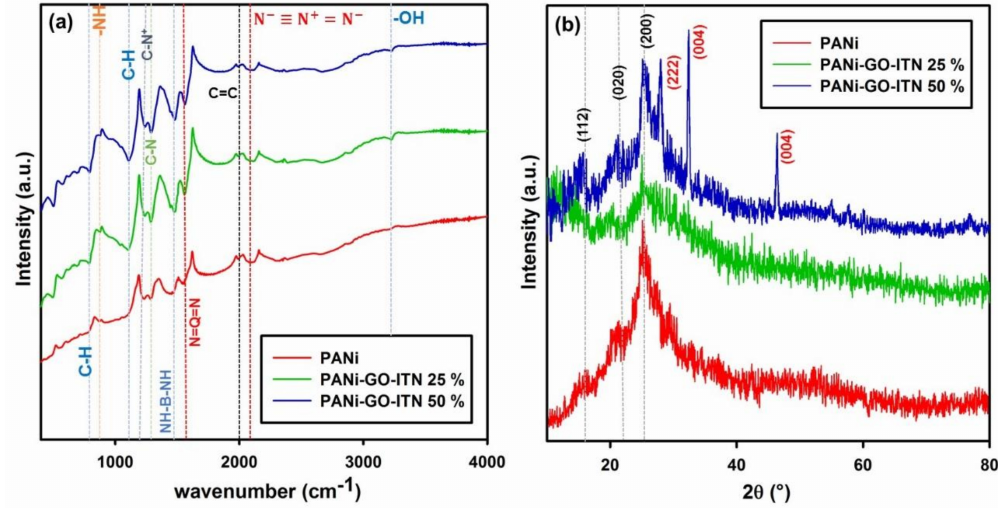
Figure 5. ( a ) FTIR and ( b ) XRD spectrums of PANi, PANi-GO-ITN 25%, and PANi-GO-ITN